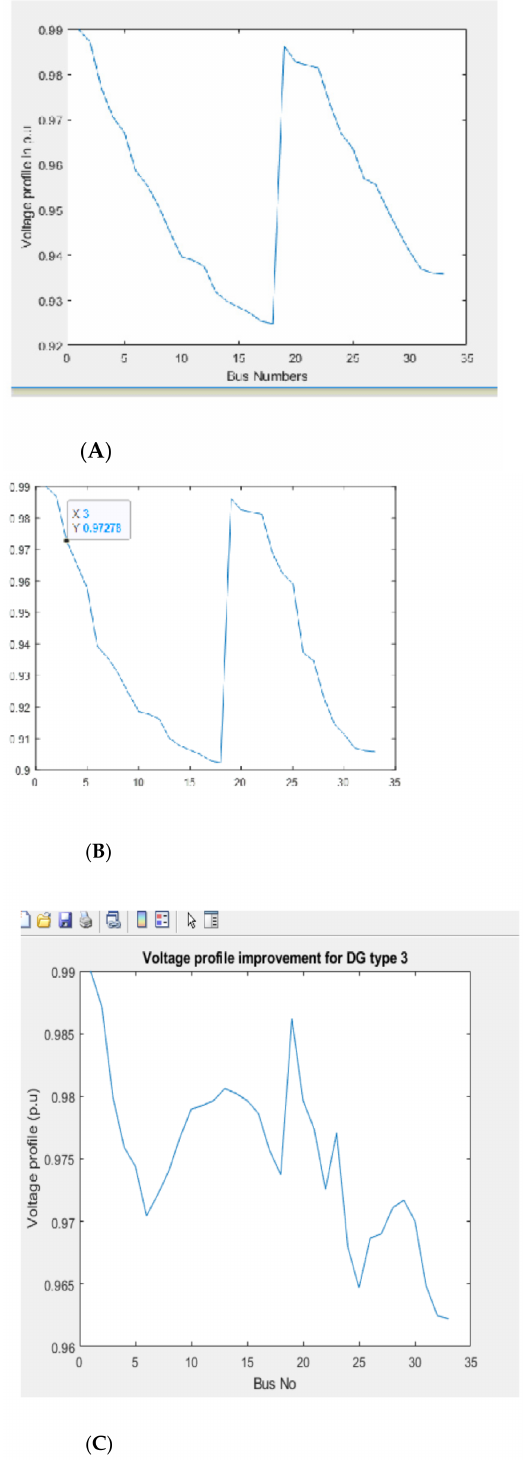
Figure 7. ( A ) Voltage profile of 33 bus test system without DG; ( B ) Voltage profile 33-bus